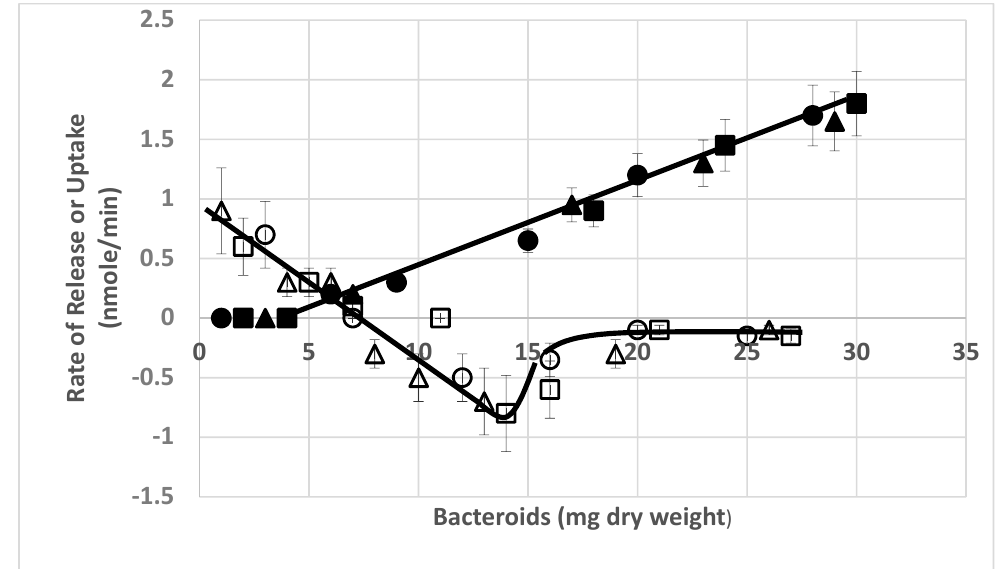
Figure 2. Ammonium release, ammonium uptake and alanine excretion as a function of the amount of ex planta B. diazoefficiens bacteroids. Positive values are ammonium release and alanine excretion. Negative values are apparent ammonium uptake. Assays were performed as described in Section 4. Values are the mean plus range of duplicate values. Partial pressure of oxygen was 0.008 atm. Open symbols (circles, squares, triangles)-ammonium; closed symbols-alanine. Each set of symbols represents a separate experiment.